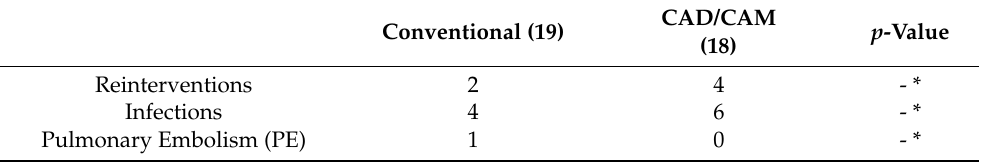
Table 3. Analyses of